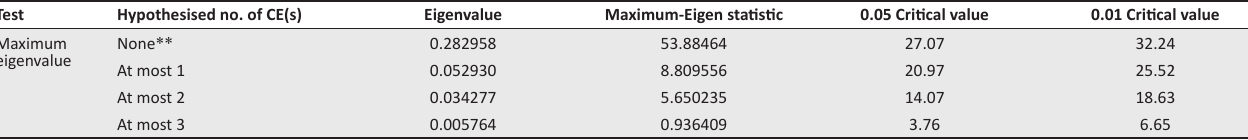
TABLE 3b: Panel Johansen cointegration maximum eigenvalue test results, 1980–2014. Test Hypothesised no. of CE(s)